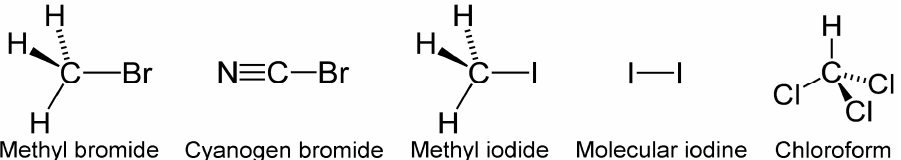
Figure 6. Chemical structures of key microalgal VHCs.